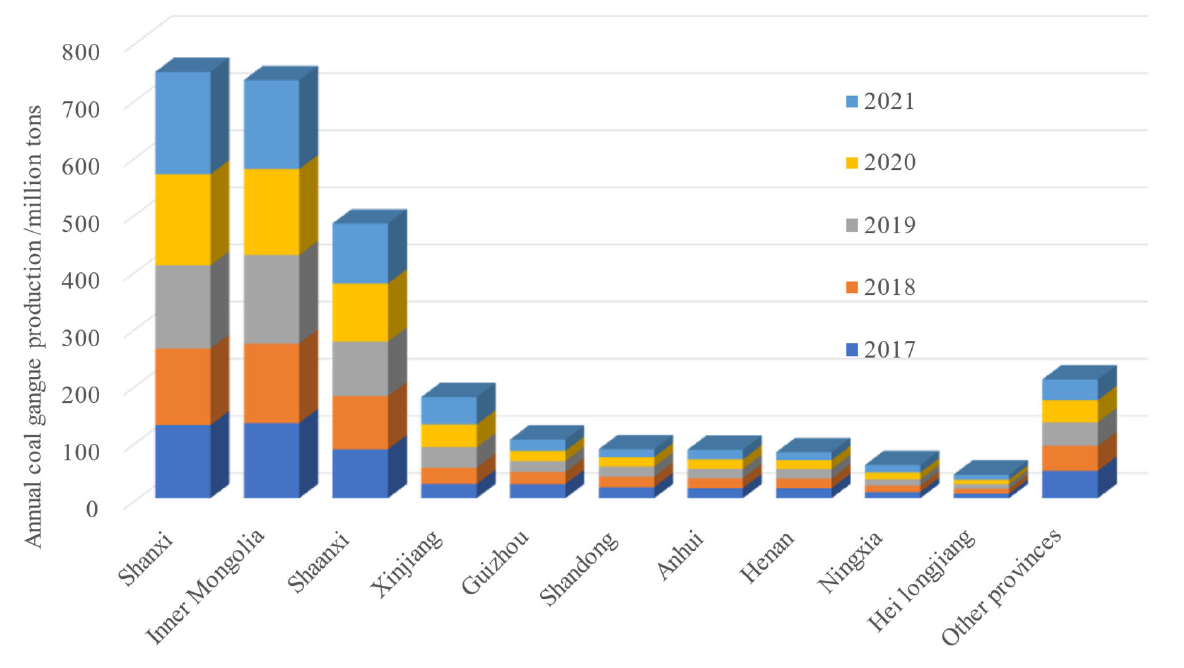
Figure 2. The annual coal gangue production in different provinces of China from 2017 to 2021.